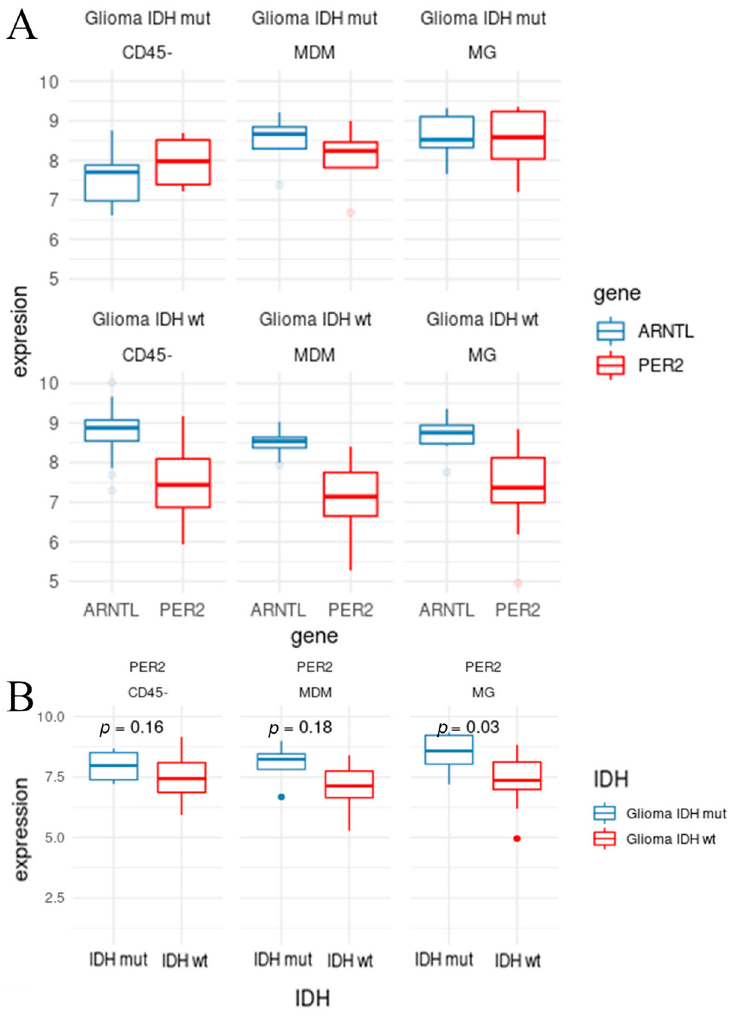
Figure 5. Clock gene expression in the immune cell composition of gliomas by IDH status. ( A ) Boxplots show expression levels of PER2 (red) and ARNTL (blue) for microglia (MG), myeloid-derived macrophages (MDM), and CD45 negative (CD45-) cells in IDH -mutated (Glioma IDH mut) and wild-type tumors (Glioma IDH wt). ( B ) Boxplot showing the expression levels of PER2 for IDH -mutated (blue) and IDH wild-type (red) tumors in MG, MDM, and CD45 cells. The t -test comparisons show that the PER2 expression levels in MG are significantly lower in IDH wild-type compared to MG in IDH -mutated tumors.